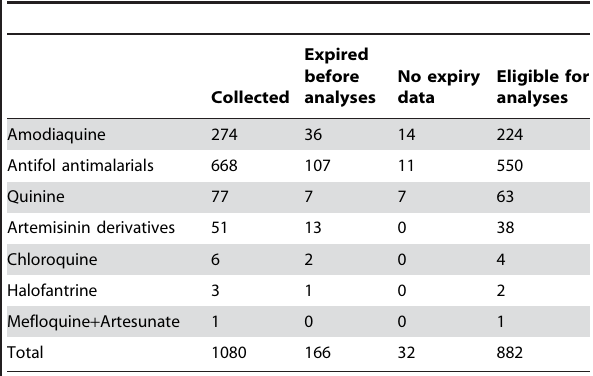
Table 1. Antimalarial drug samples collected and eligible for analyses.